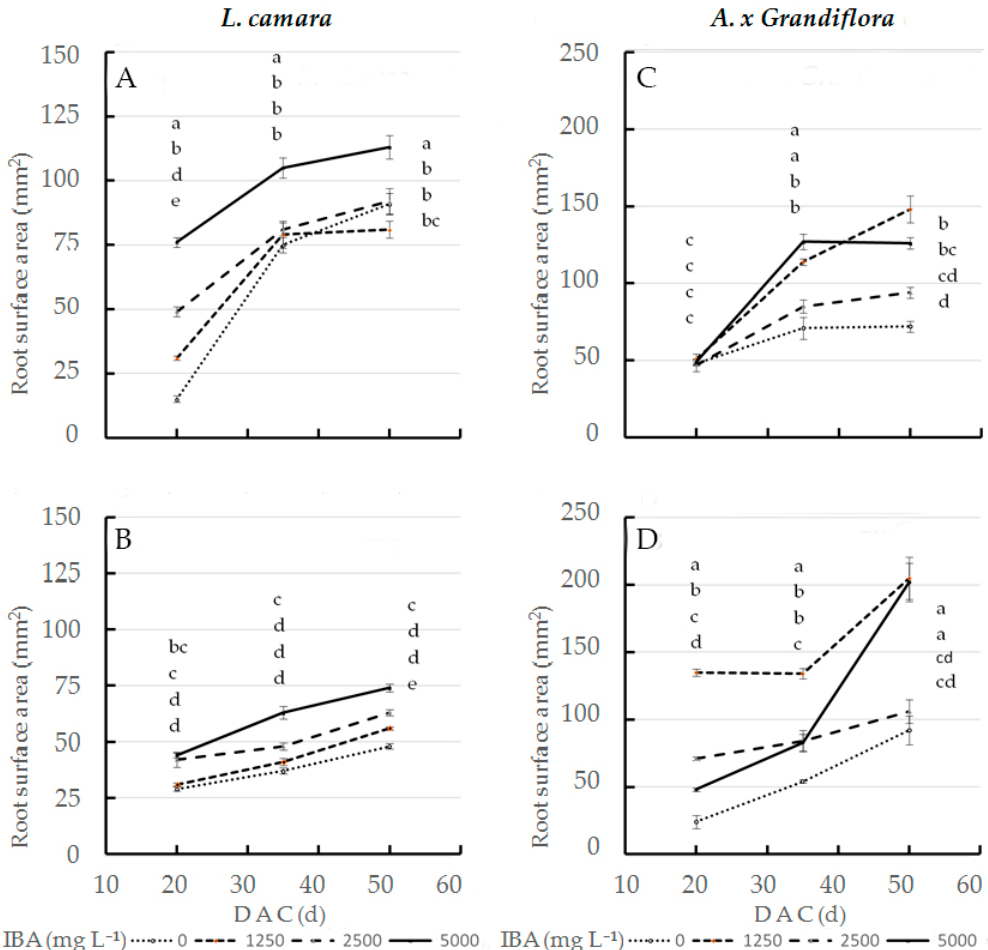
Figure 2. Root surface area at three sampling dates in two L. camara cultivars (( A ) ‘Little Lucky’, ( B ) ‘Yellow’) and two A. x grandiflora cultivars (( C ) ‘Canyon Creek’, ( D ) ‘Edouard Goucher’) treated with different IBA concentrations ( n = 8). Different letters denote significant differences ( p ≤ 0.05) among treatments for the same sampling date. Data shown are means ± SE of three replicates. Table 2. Root diameter in wild sage and glossy abelia at 50 DAC, according to IBA concentration As for root diameter (Table 2) in wild sage, interaction was not significant at three and sampling dates; in glossy abelia, at 50 DAC, the 5000 mg L − 1 IBA concentration had the same effectiveness in both cultivars, showing a maximum value of 0.57 mm in cv1 and of